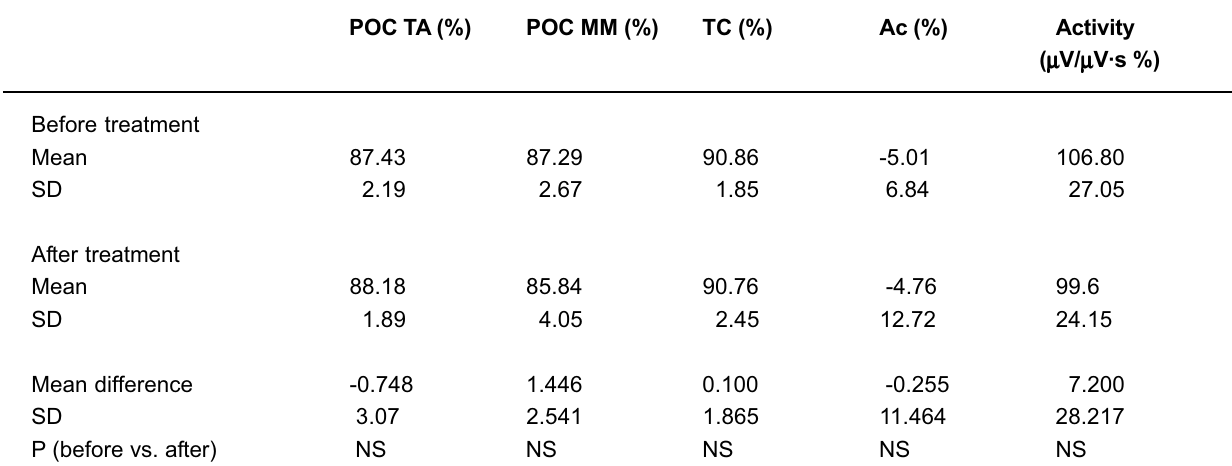
SD: standard deviation; POC: percentage overlapping coefficient (index of left-right muscular symmetry); TC: torque coefficient (potential lateral displacing component); Ac: Activity index (ratio between MM and TA potentials); Activity, unit: pooled muscular activity; P (before vs. after): probability of a paired Student’s t test; null hypothesis: no difference before and after treatment. NS: not significant. p > 0.05. SD = standard